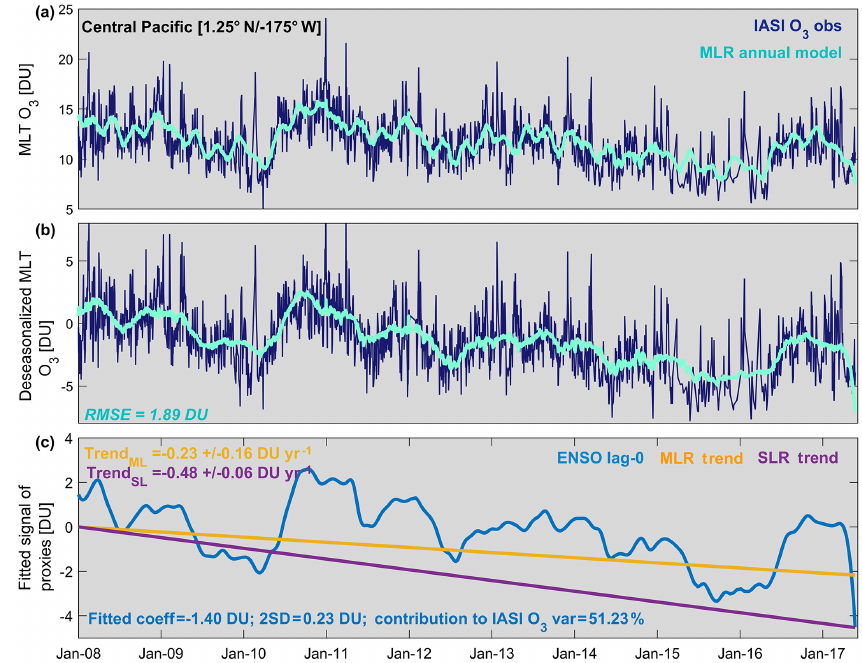
Figure 8. Daily time series of (a) O 3 measured by IASI (dark blue) and adjusted by the multivariate annual regression model (light blue), (b) the deseasonalized O 3 and (c) the fitted signal of ENSO proxy (one of the main retained proxies in the multivariate regression model) calculated as x j X norm ,j (given in DU) along with the adjusted trends derived from the single and the multivariate linear regressions (SLR and MLR) over the equatorial central Pacific (region of negative ENSO “dynamical” effect). The RMSE of the MLR fit and the fitted SLR and MLR trend values are also